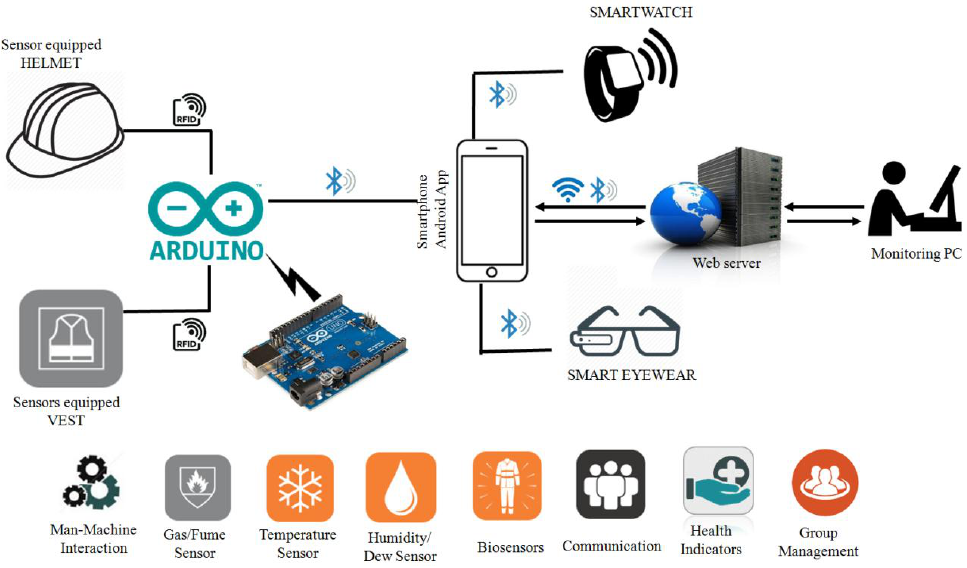
Figure 4. Wearable technology-integrated embedded wearable safety communication system.